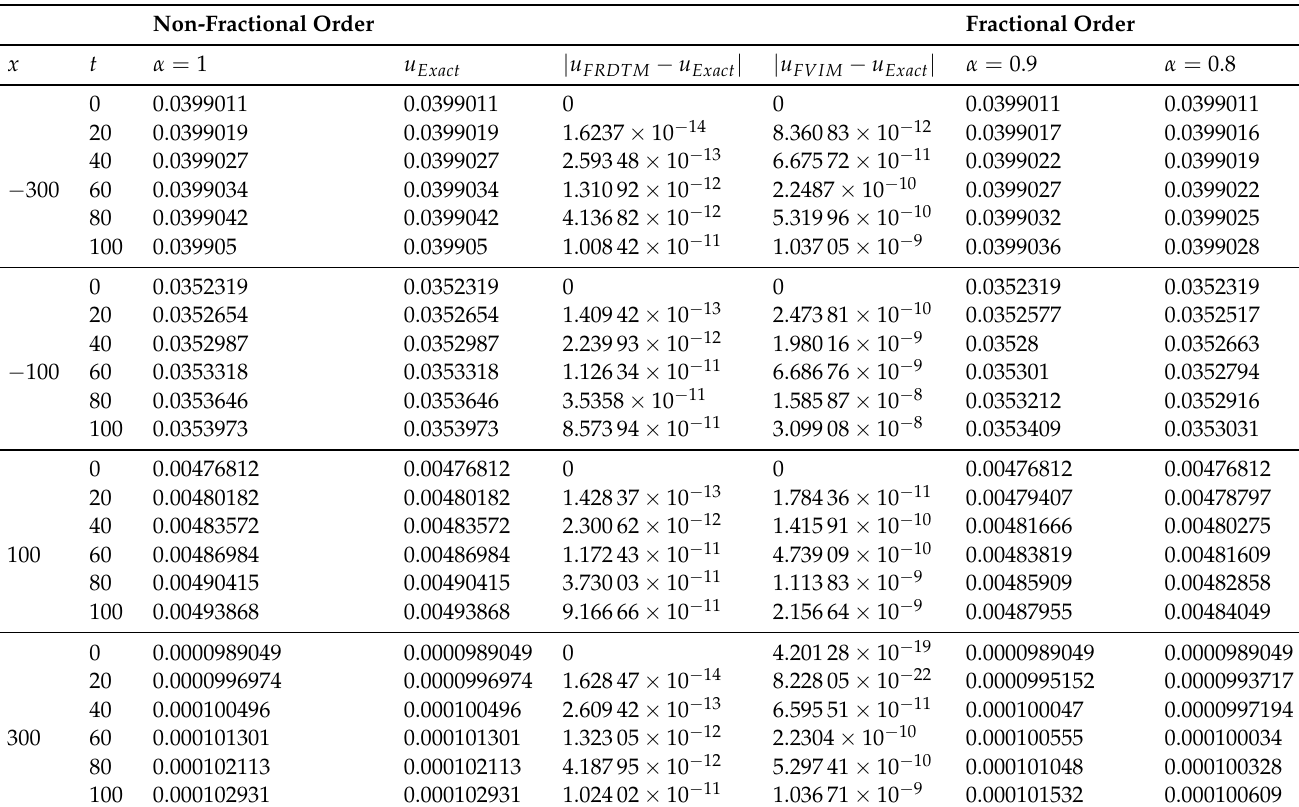
Table 2. Approximate numerical solution for u 3 ( x , t ) by FRDTM at different values of α and a comparison of absolute errors at α = 1 for FRDTM with